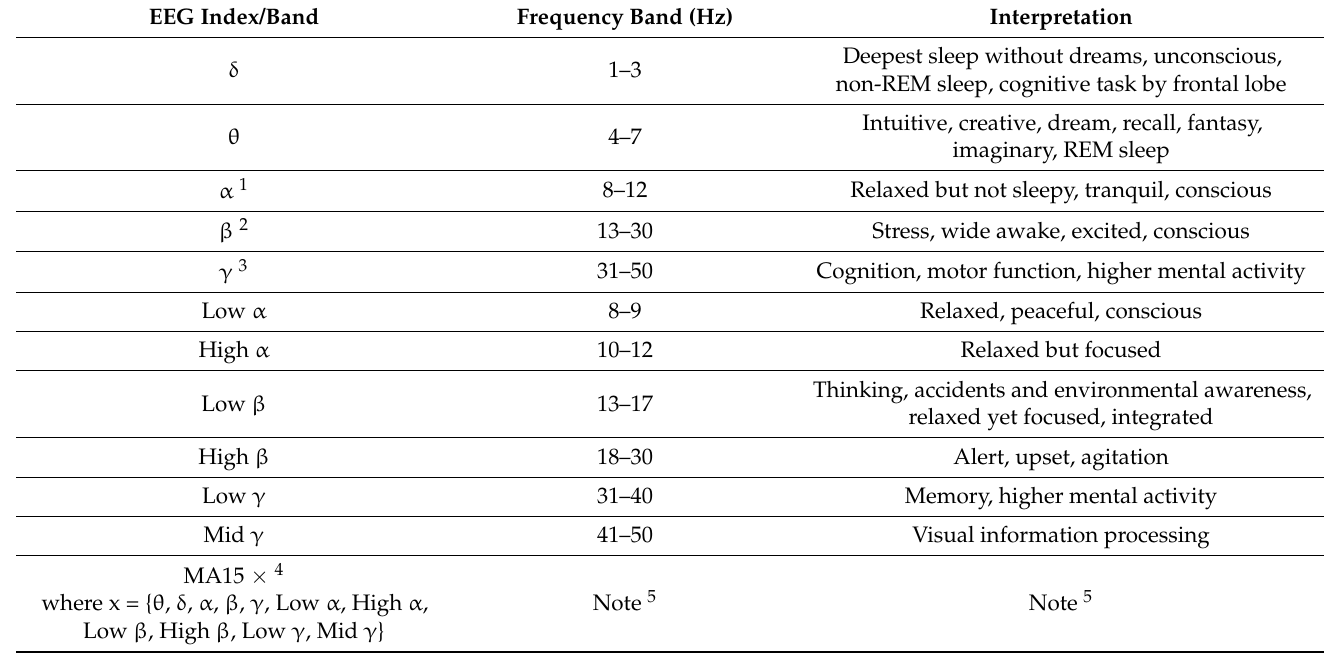
Table 1. Electroencephalogram (EEG) indexes used in this